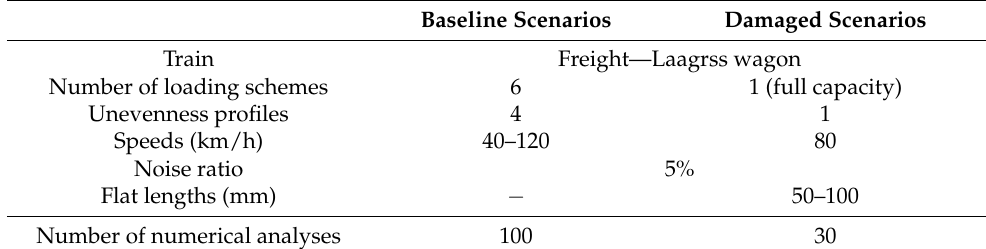
Table 1. Damaged and undamaged scenarios.